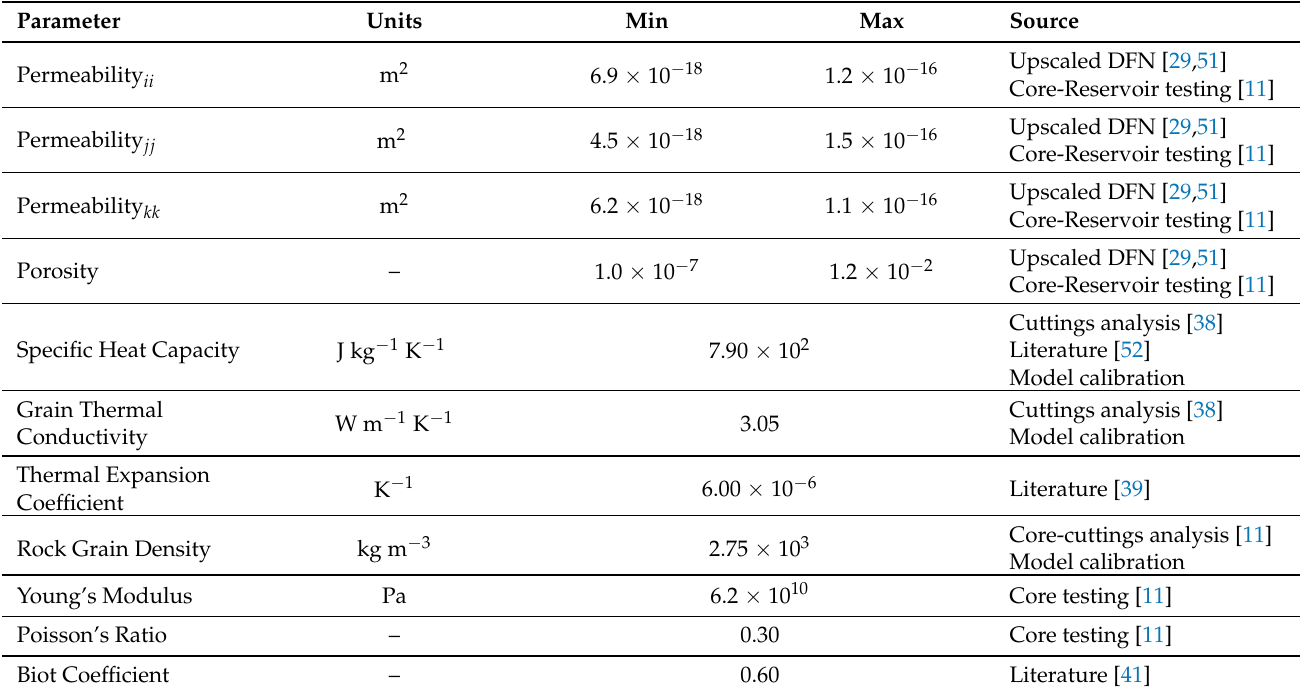
Table 2. Properties for the granitoid reservoir used in the native state simulation. Values based on field and laboratory measurements and model calibration.